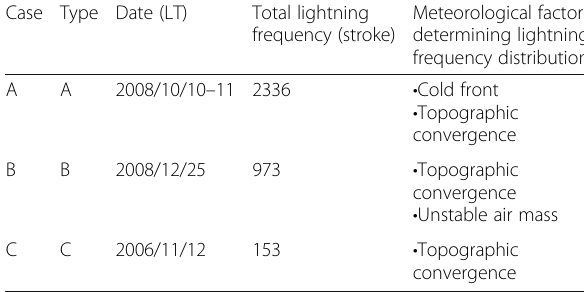
Table 4 Case study